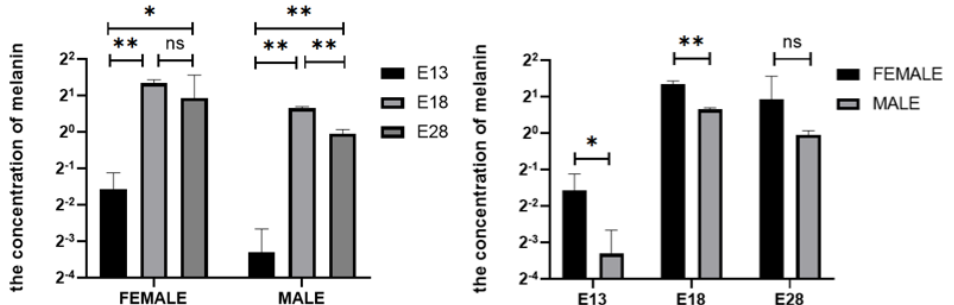
Figure 6. Melanin content of dorsal skin feather follicle of Holdobaggy geese during embryonic stage. Note: ns no significant difference ( p > 0.05), * Significant difference ( p < 0.05), ** extremely significant difference ( p < 0.01). The results are expressed as the mean ± SEM. n:3.